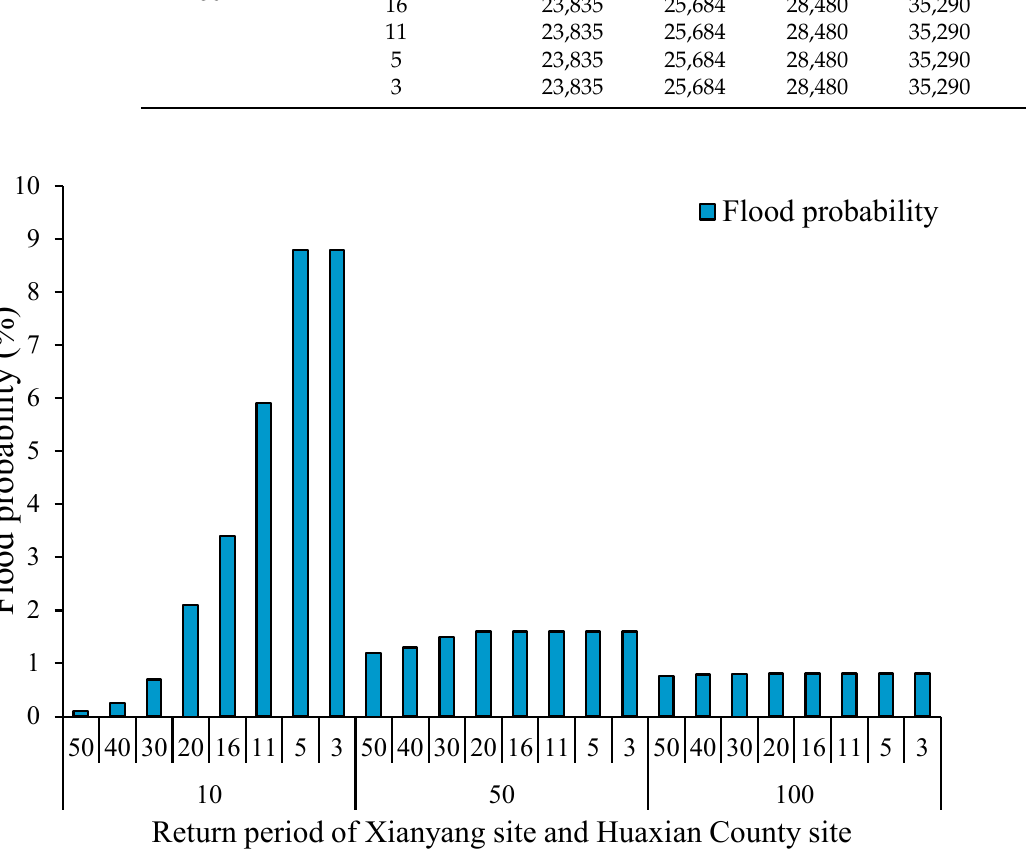
Figure 12. Flood probability of Zhangjiashan under different return periods of Xianyang and Huaxian County.